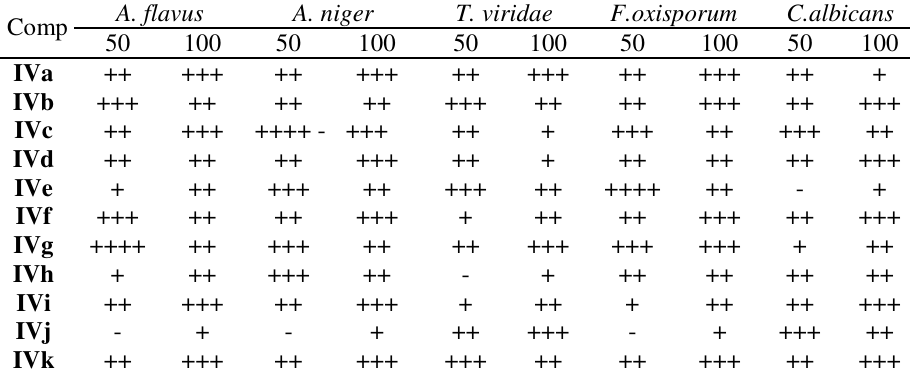
Table 6. Antifungal activity of the synthesized IV(a-k) against various fungi at two different concentrations (ppm)